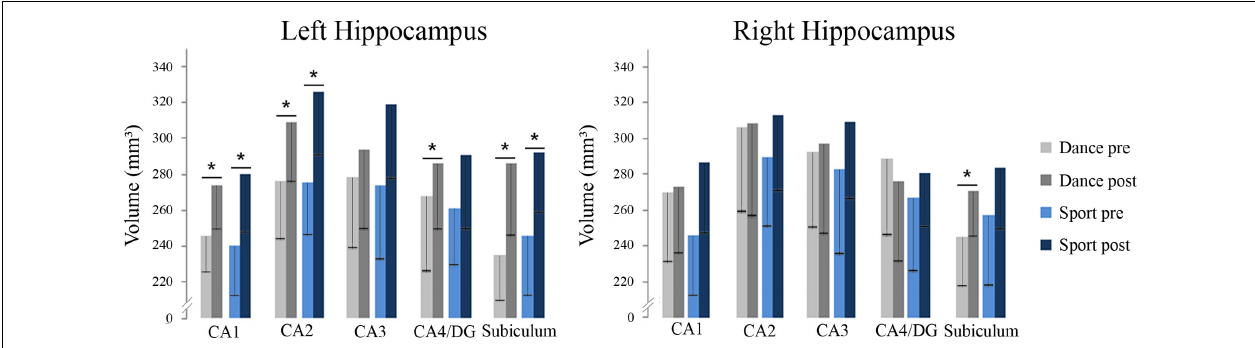
FIGURE 4 | Volumes of hippocampal subfields in dance and sport group at baseline and after 18 months of intervention including standard deviation (DG, dentate gyrus; CA, cornu ammonis; ∗ p < 0.05).